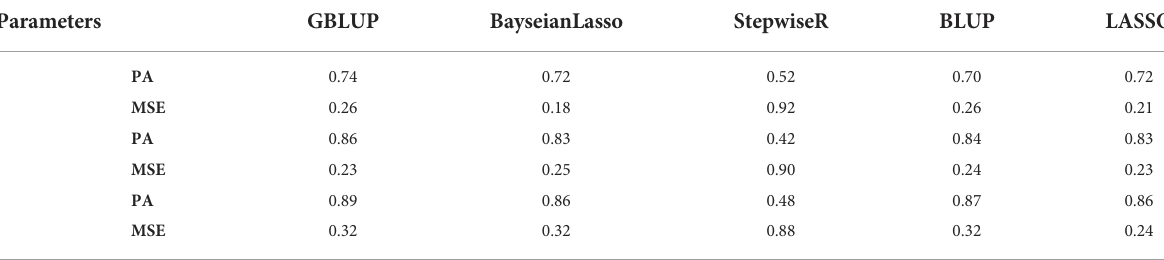
TABLE 1 Predictive ability and MSE of GEBVs for different parametric methods using simulated dataset at different levels of heritability (h 2 ). h 2